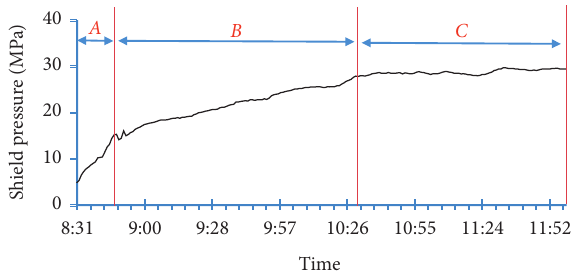
Figure 1: Real supporting load variation after the initial setting in a typical cycle.